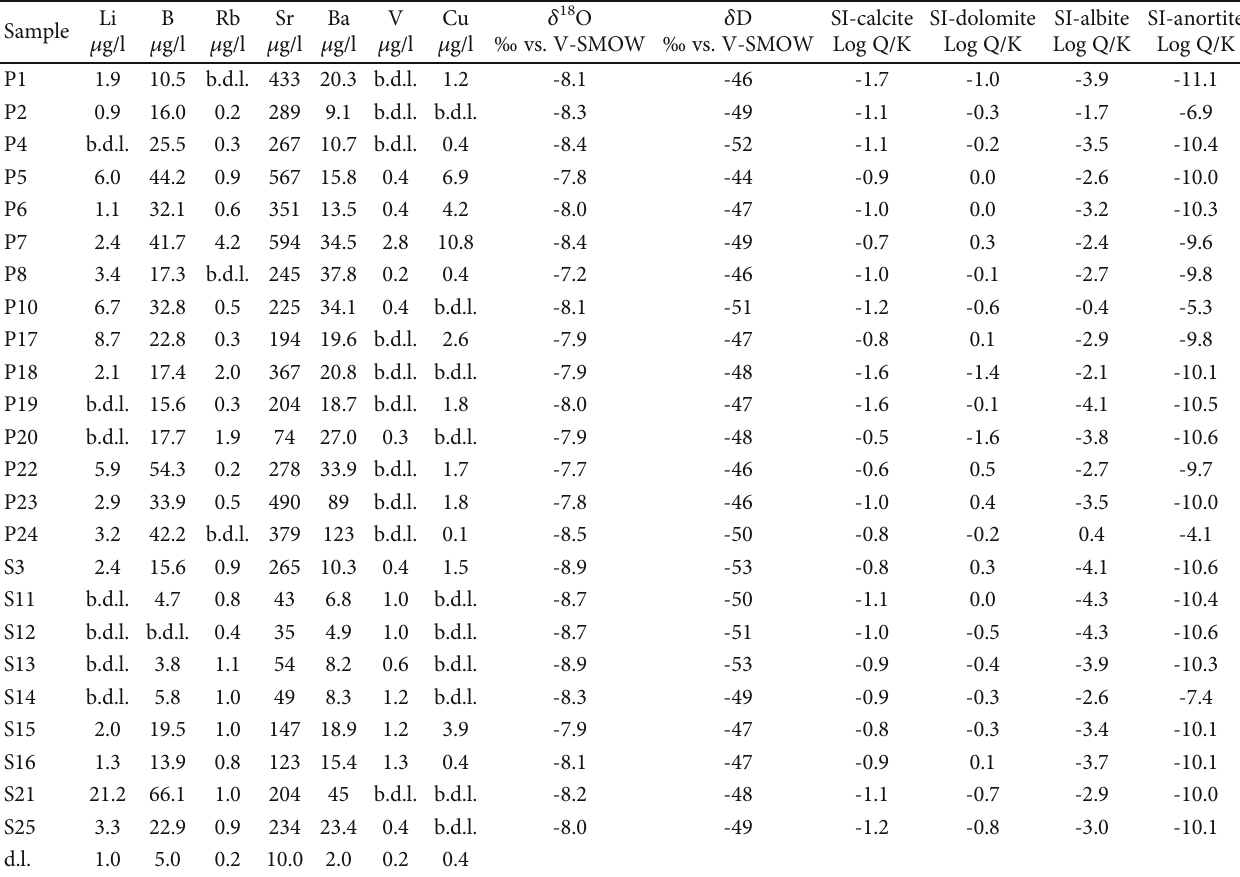
Table 2: Concentrations of selected minor elements, isotopic data, and saturation index (SI) in HAV groundwaters. Sample